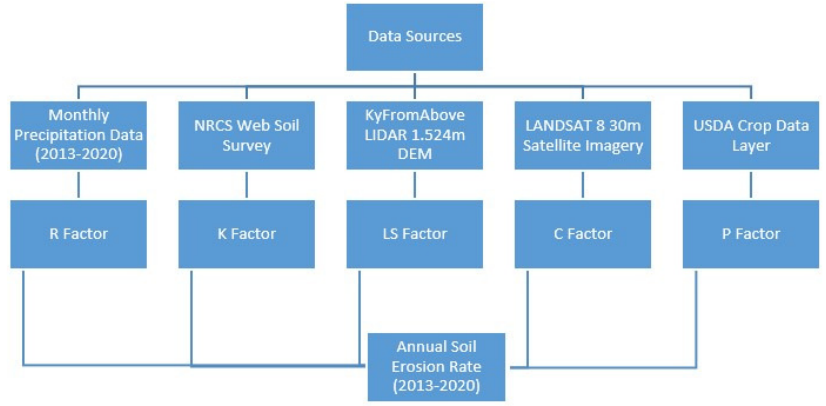
Figure 2. Flowchart of Methodology.